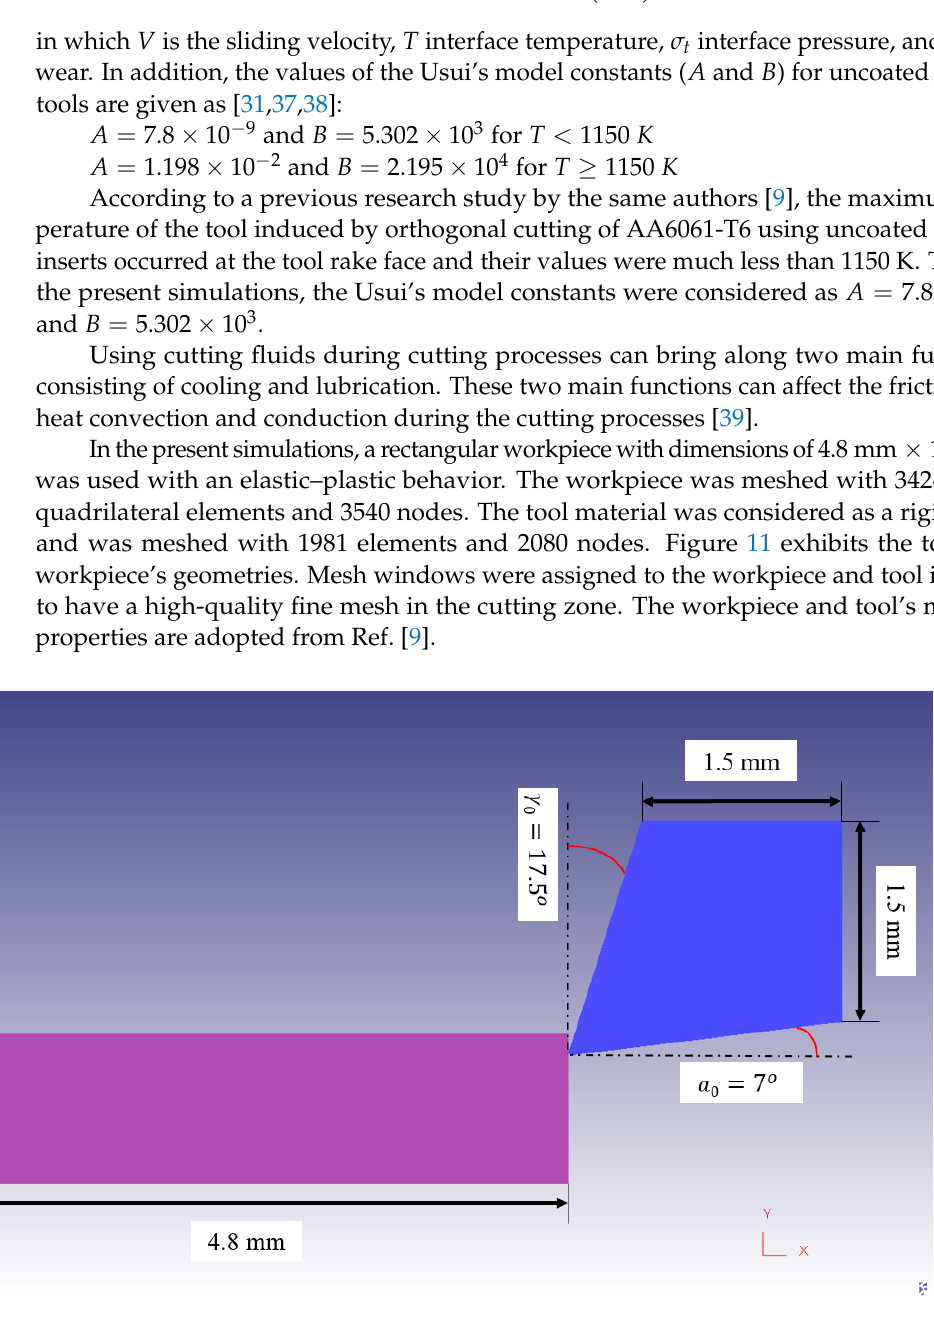
Figure 11. The geometry and dimensions of the tool and workpiece in FE modeling. Residual stresses were modeled and extracted during two steps: cutting and stress re- laxation processes. In the first step, cutting is conducted to reach the steady-state condition in which machining forces, temperature, strains and stresses, and chip thickness remain almost constant with time. As displayed in Figure 12, in both horizontal and vertical directions, the top and right sides of the cutting tool are fixed. Moreover, the bottom and left sides of the workpiece are fixed in vertical direction. The workpiece material